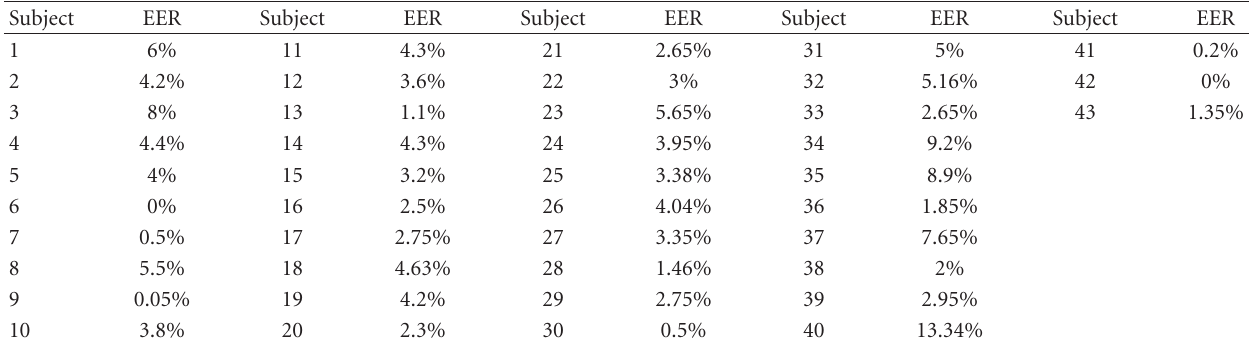
Figure 3: Detected bursts and respective emotion consistency ( q i ) for all subjects in the database (N.B.: the above bursts are not necessarily of the same duration, i.e., variable-length durations may be detected). The average state confidence is 96.47%. Table 1: Equal error rate for each individual in the active arousal database, after template updating. Mean equal error rate is